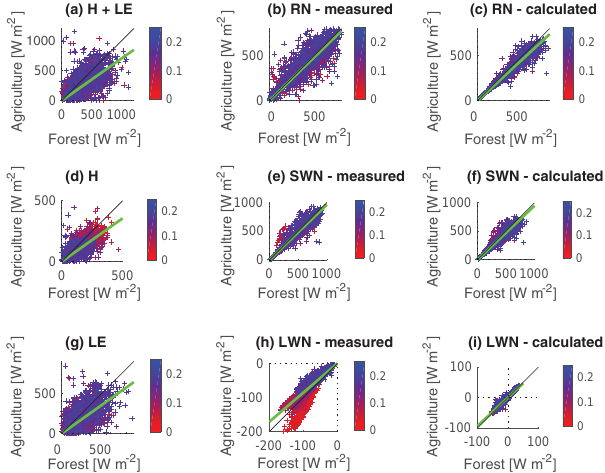
Figure 5. Comparison between fluxes measured over the savanna forest and the field. In each plot, the color indicates soil volumetric water content: red is dry and blue is wet. The least squares regres- sion lines are shown in green and the 1:1 lines are in black. Mea- surements over the savanna forest are on the x axis and those over agriculture are on the y axis. All fits were significant ( p <0.005). Panels (b, e, h) show the components of net radiation calculated with the net radiometers. Panels (c, f, i) show the components of net radiation calculated using parameters measured at the small meteo- rological stations: air temperature (Ta), incoming shortwave radia- tion (SW), and soil temperature (Ts); see the